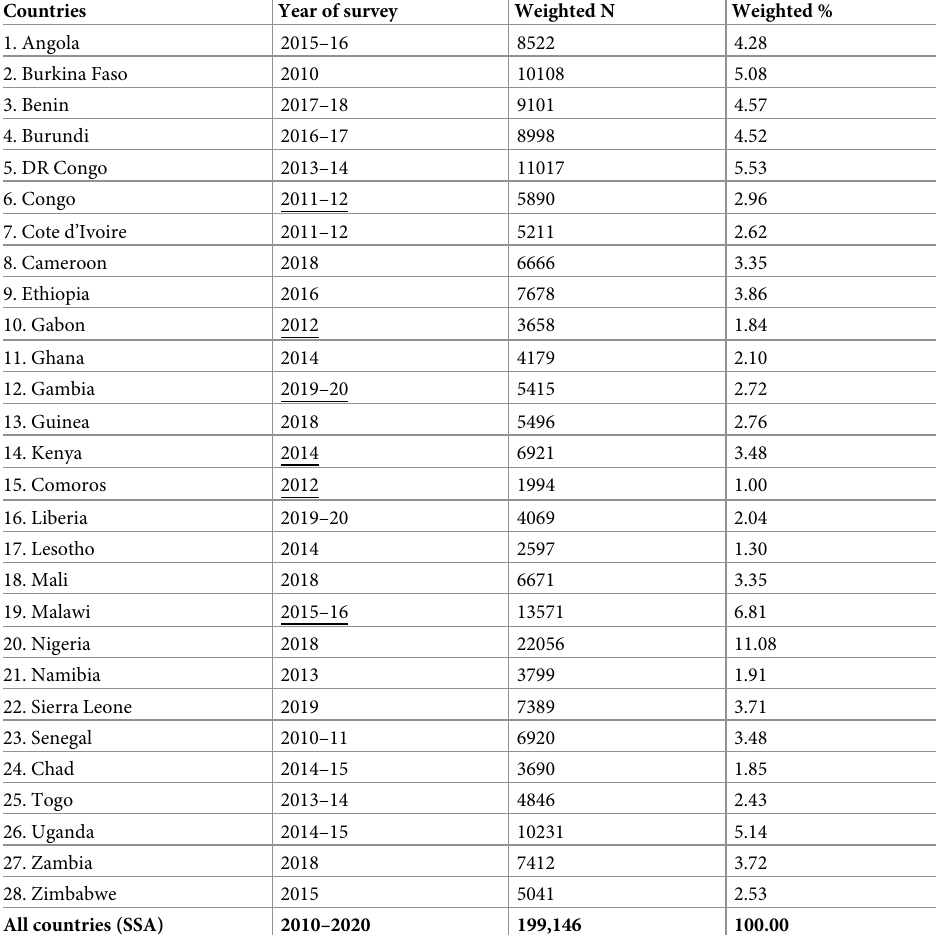
Table 1. Description of the